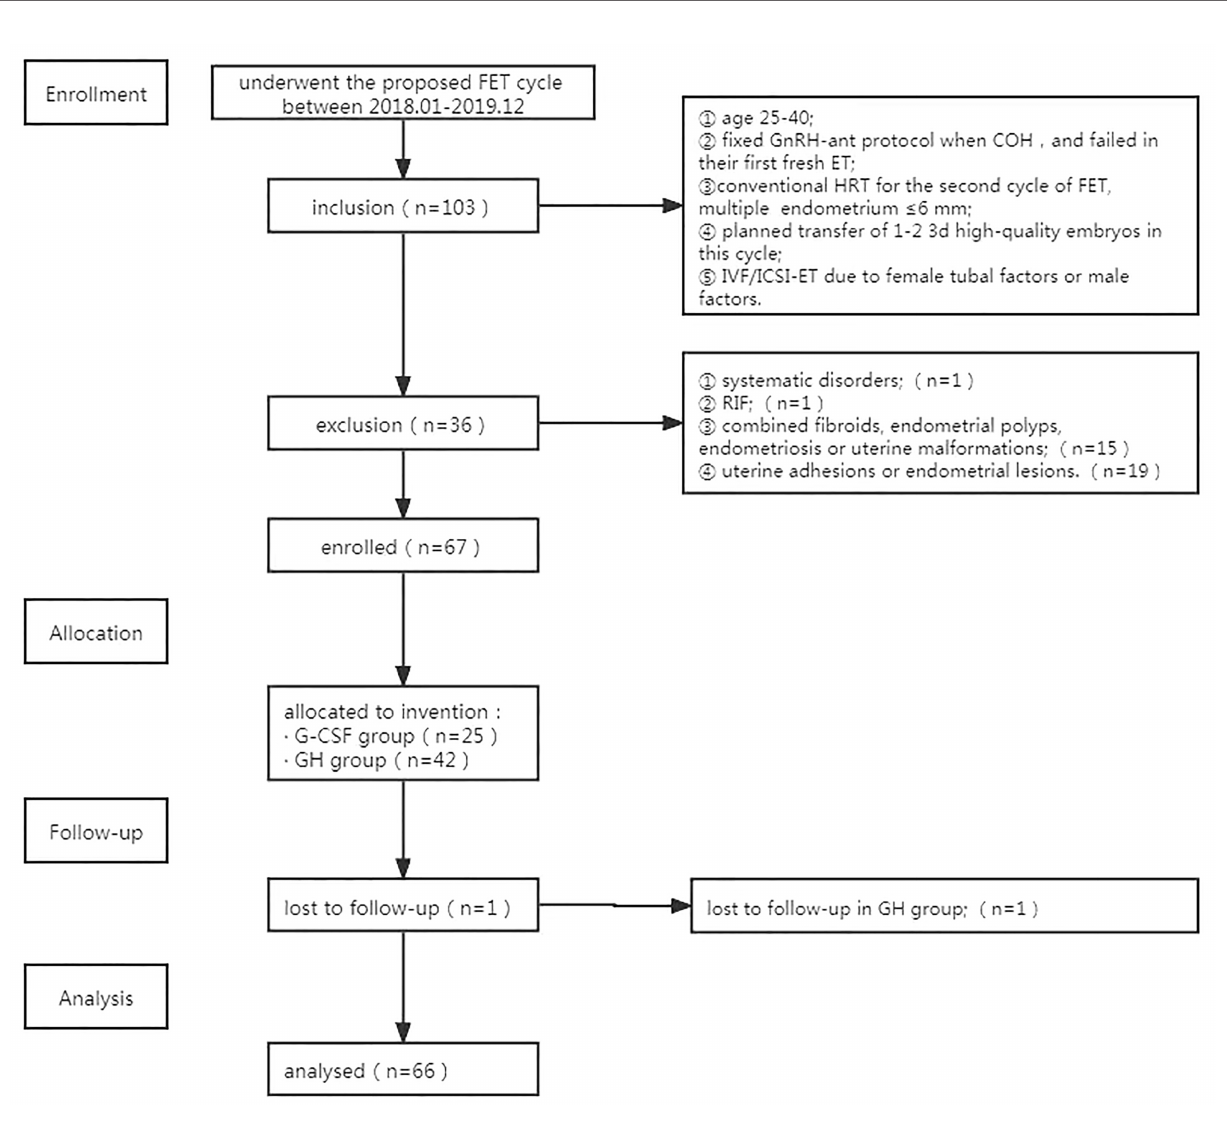
FIGURE 1 | Flowchart of trial